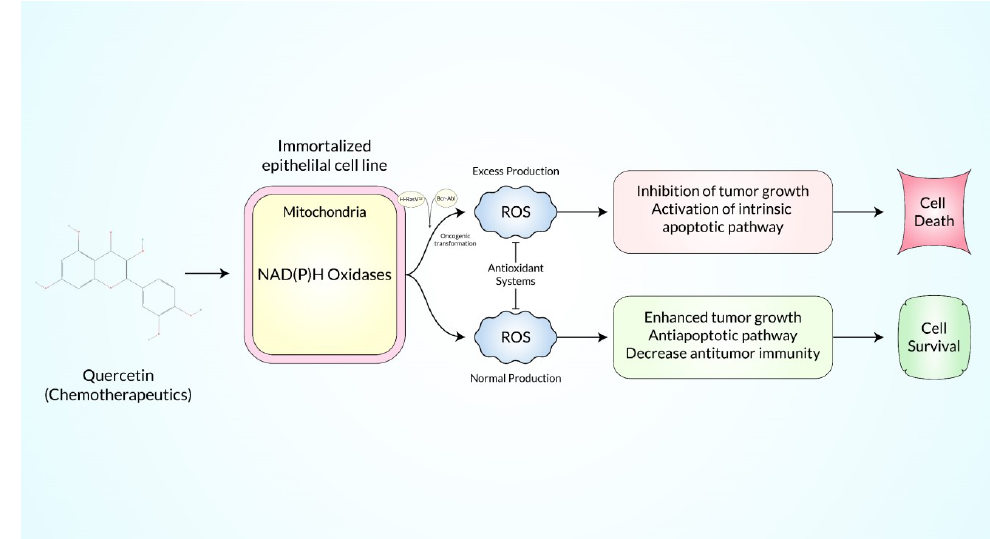
Figure 7. The anticancer pathways and mechanisms of action induced by quercetin .